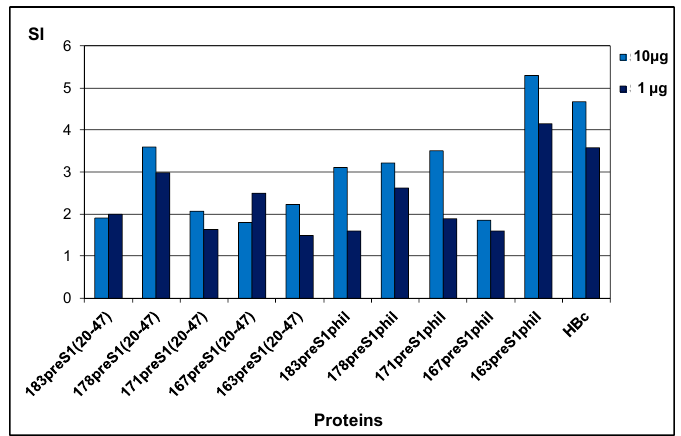
Figure 11. T-cell proliferation in splenocytes of BALB/c mice immunized with HBc-preS1 VLPs. Stimulation indexes (SI) were calculated after stimulation with HBc183 (1 µ g and 10 µ g) on day 42 after the first immunization. Types of VLPs used for immunization are shown under the bars.